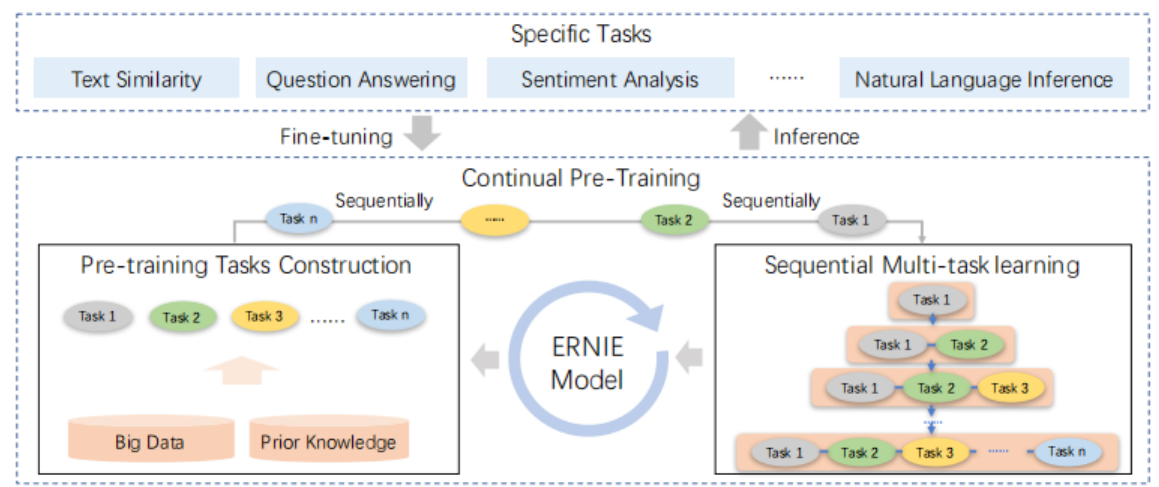
Figure 3 The framework of ERNIE 2.0 builds pre-training tasks and models incrementally. Fine-tuning through continuous multi-task learning for various specific tasks [14].